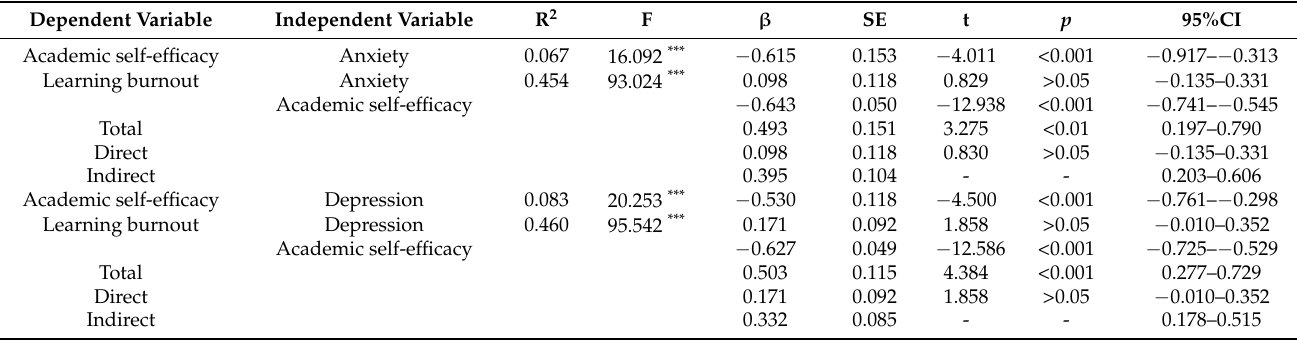
Table 3. The Mediation Effect of Academic Self-efficacy in Anxiety, Depression and Learning Burnout ( n =